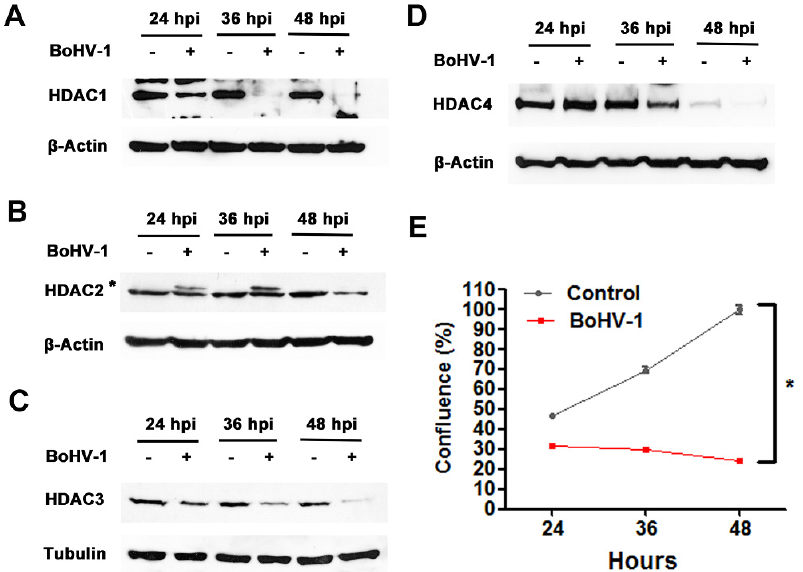
Figure 1. The effects of BoHV-1 infection had on the expression of histone deacetylases (HDACs). ( A ) A549 cells in 60 mm dishes were mock infected or infected with BoHV-1 at an MOI of 0.1 for 24, 36 and 48 h. The cell lysates were then prepared for Western blot to detect the protein expression of HDAC1 ( A ), HDAC2 ( B ), HDAC3 ( C ) and HDAC4 ( D ). Data shown are representative of two inde- pendent experiments. ( E ) A549 cells of sub-confluent in 24-well plates were infected with BoHV-1 at an MOI of 0.1. At an indicated time point the cells were collected, stained with trypan blue, counted the numbers of live cells. Cell confluence that indicated growth were calculated as de- scribed in materials and methods. Data shown are means of three independent experiments. Statis- tical difference was determined using a one-way analysis of variance test (ANOVA). * p < 0.05.